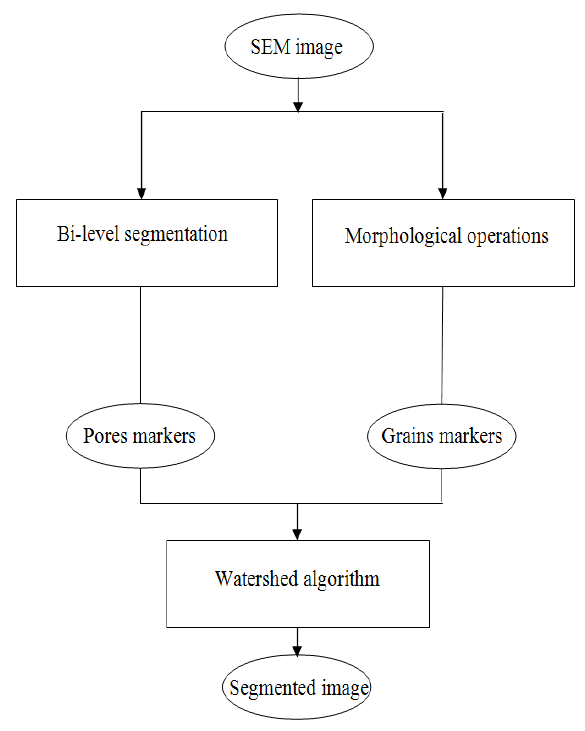
Figure 2. Image segmentation workflow based on statistical and spatial method. 2 Fig. 2. Image segmentation workflow based on statistical and spatial